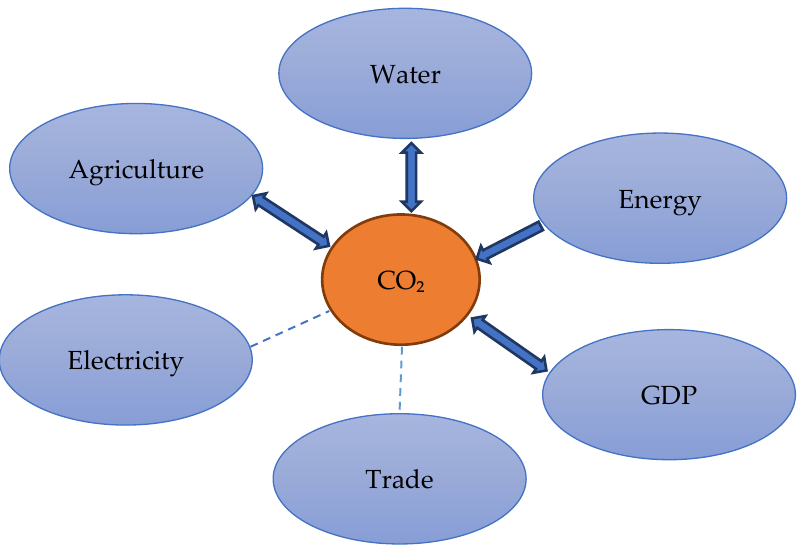
Figure 2. Graphical representation of Granger non-causality test results. Note: ⇔ —means bi- directional causality; ⇐ —means unidirectional causality; —- —means no causality.